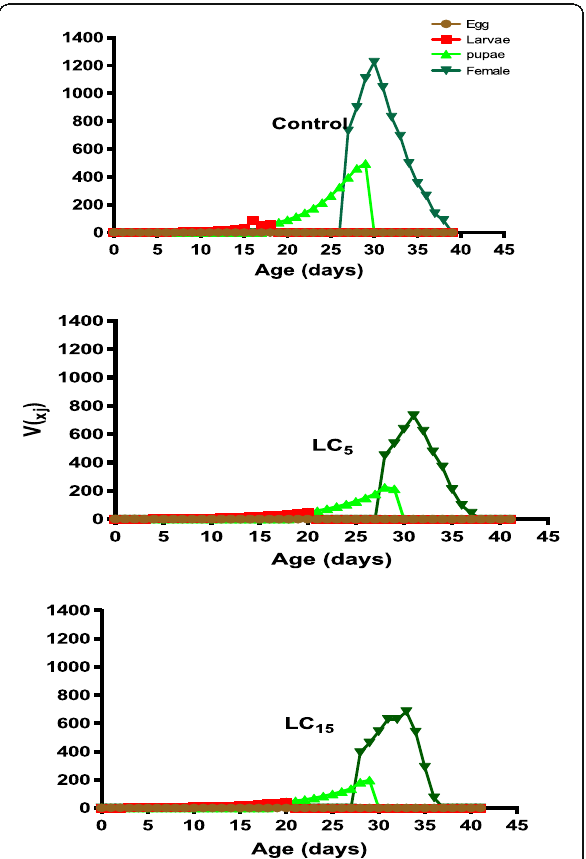
Age-stage specific reproductive value ( V ) indicates the x,j status of future offspring from age x to stage j (Fig. 2). The males curve was not included in V graph because males x,j contribution in future population was not defined. V x , j values declined in LC and LC treated larvae compared 5 15 with the control group.